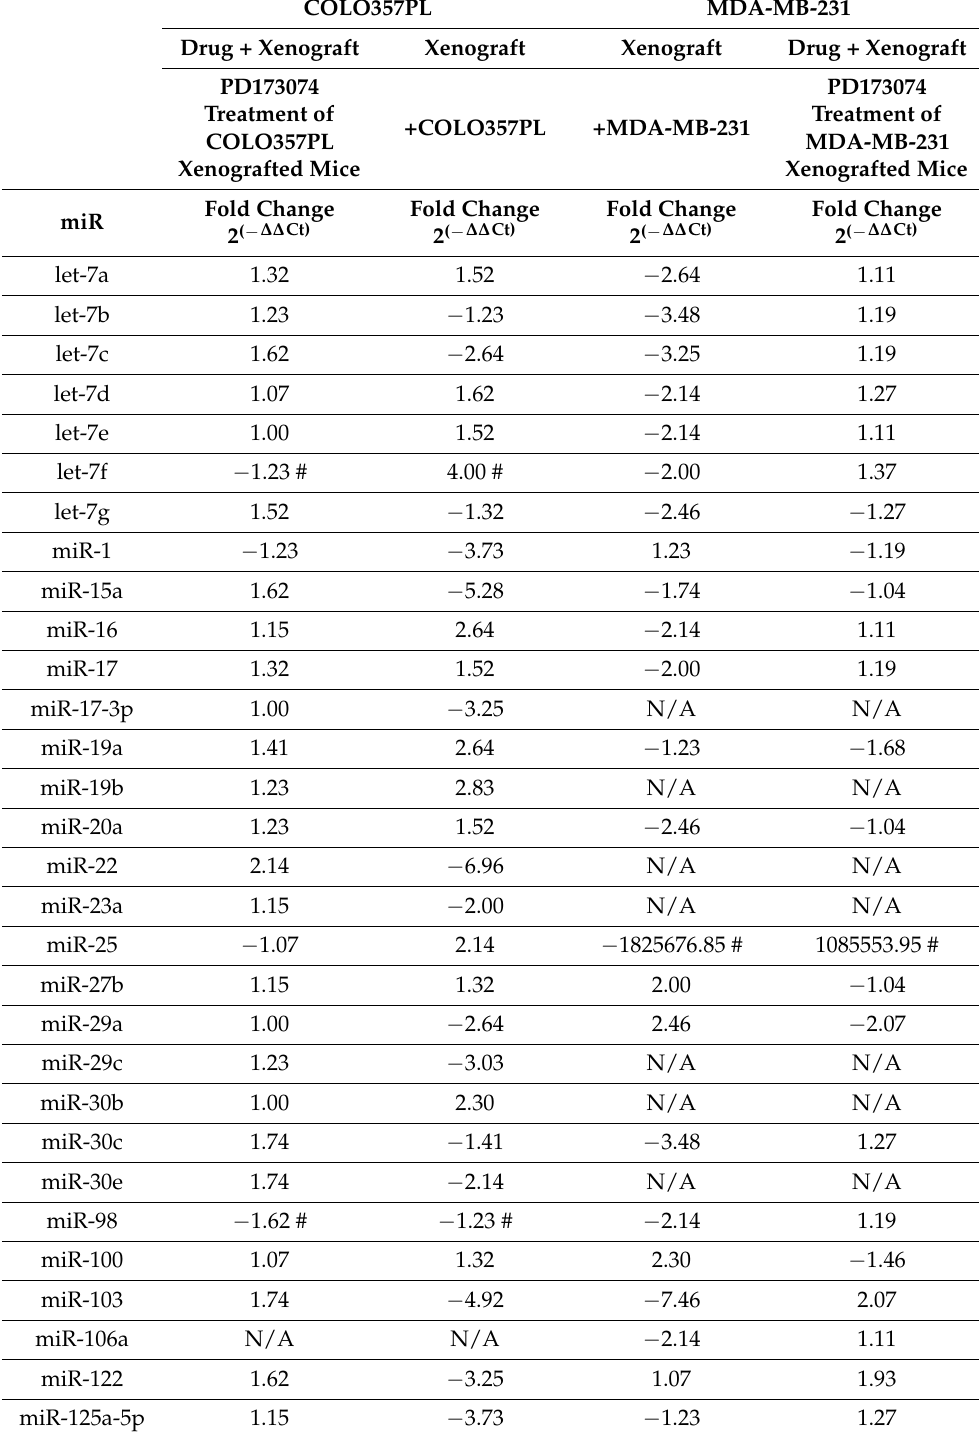
Table 1. Serum miRs related to the presence of COLO357PL and MDA-MB-231 xenograft tumors and serum miRs related to the short-term treatment with the FGFR inhibitor, PD173074. The expression levels of 352 serum miRs in COLO357PL and 88 serum miRs in the MDA-MB-231 xenograft mouse model were analyzed by qPCR and normalized for the respective median Ct value. miRs with Ct < 30 that were changed by ≥ 2-fold in at least one comparison are presented. Additionally, serum miRs changes after short-term treatment with PD173074 in both xenograft models are presented. Fold changes in serum miR expression after PD173074 treatment are presented for every tumor-related miR with Ct < 30, as well as those ≥ 2-fold deregulated after PD173074 treatment. COLO357PL